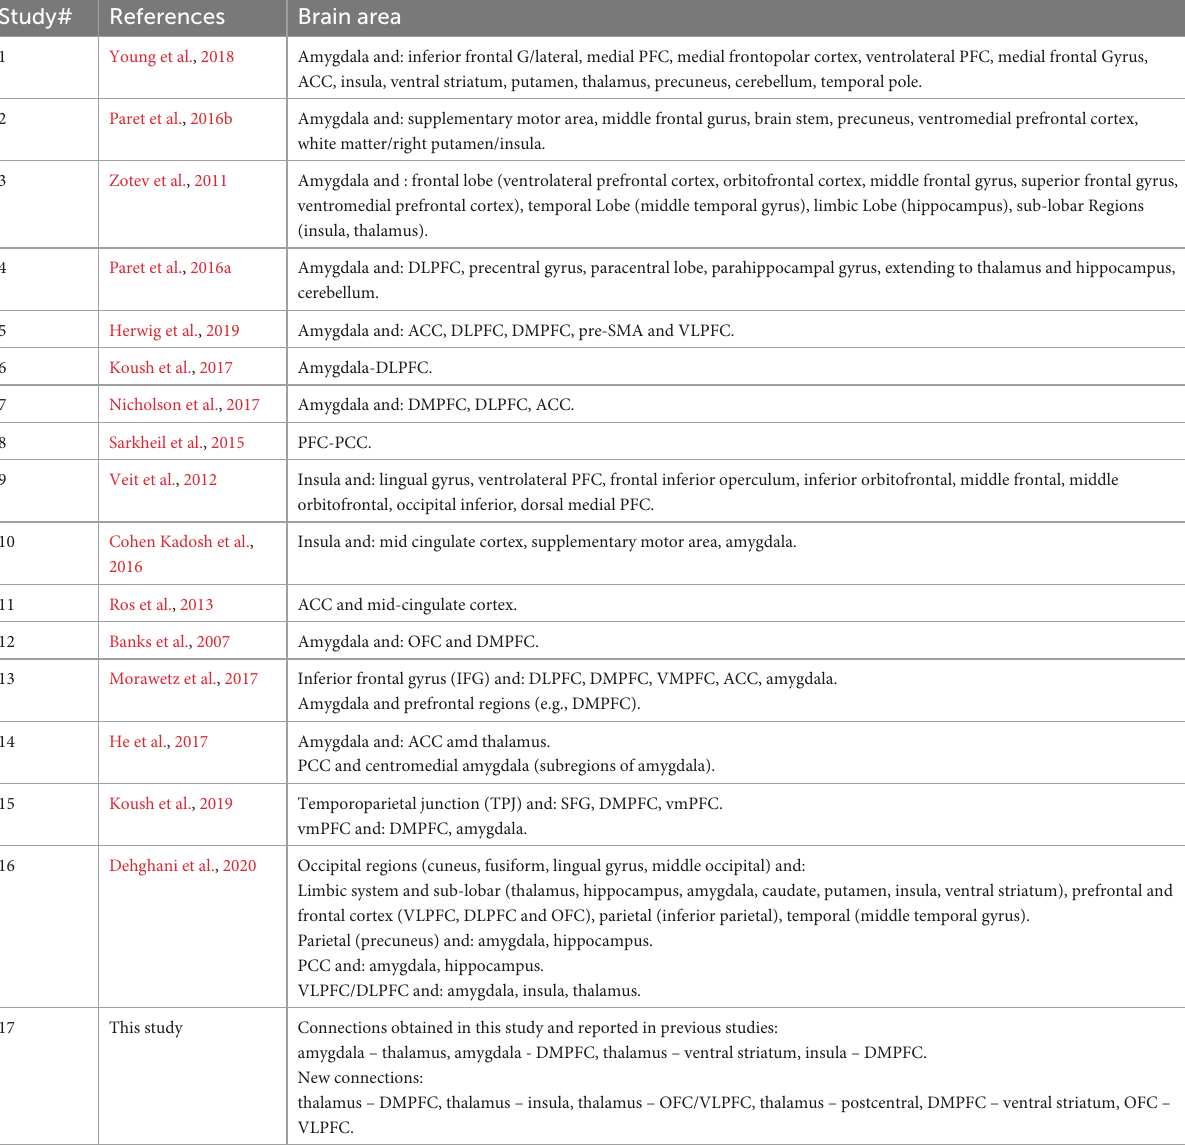
TABLE 3 Significant connectivity obtained in previous emotion regulation researches and this study as a result of